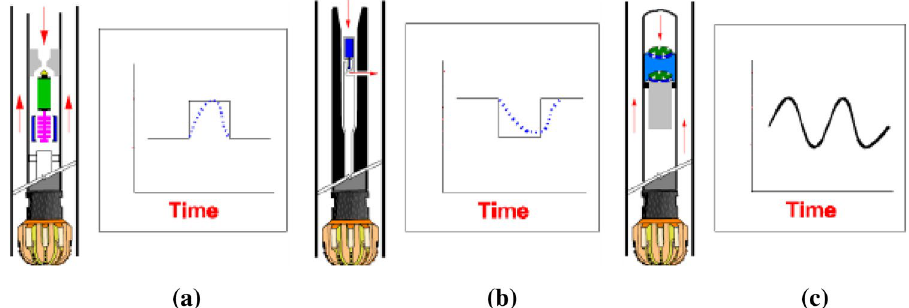
Fig. 1 Generated mud pulses: positive ( a ), negative ( b ) and continuous ( c